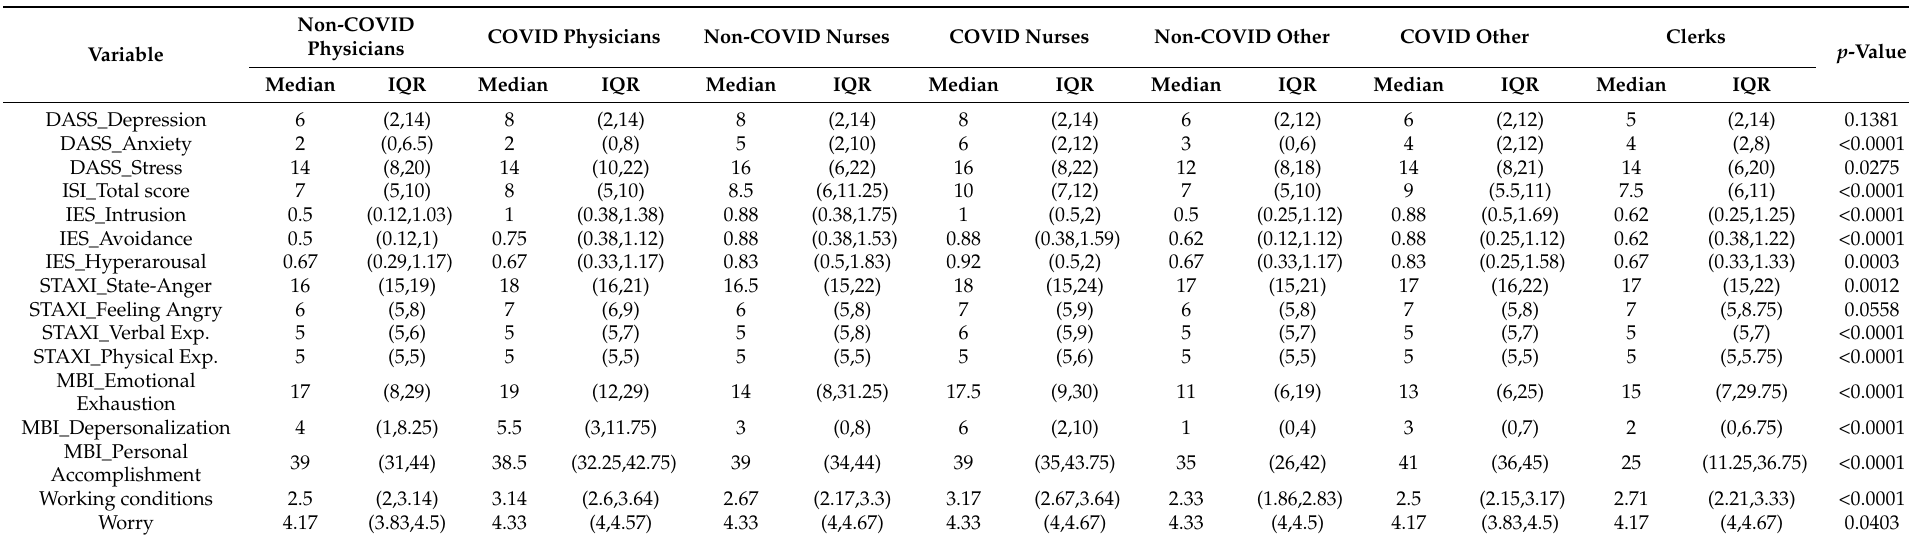
Table 1. The Kruskal–Wallis test